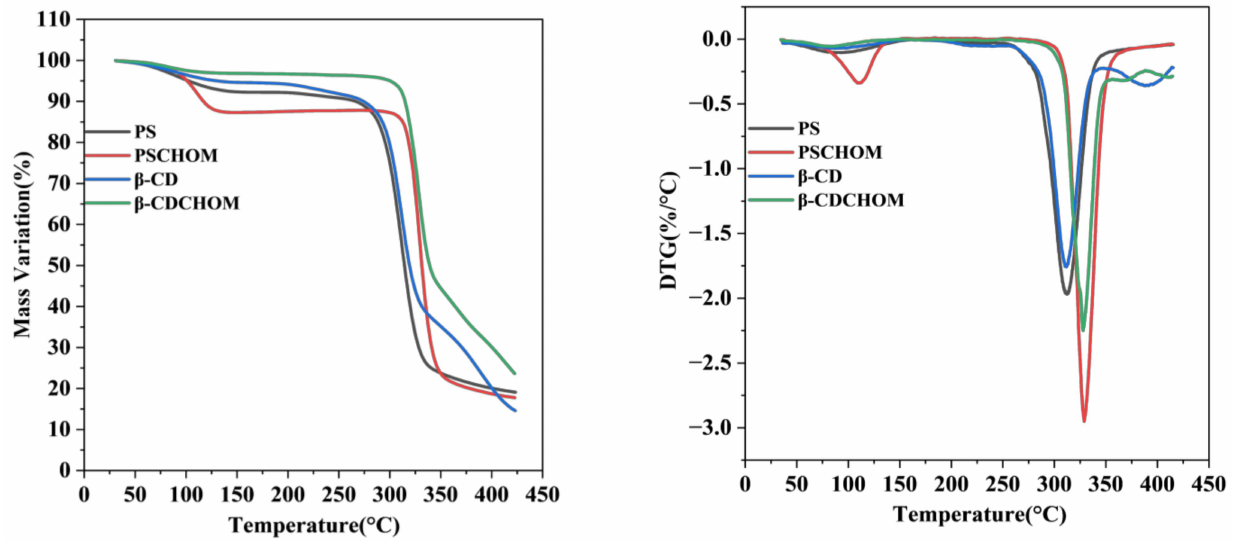
Figure 3. Integrated thermal analyses of β -CD, PS and their CHO microcapsules (( left ): TG; ( right ): DTG). β -CD, β -Cyclodextrin; PS, Porous starch; CHO, cold-pressed hickory oil; β -CDCHOM, β -cyclodextrin cold-pressed hickory oil microcapsule; PSCHOM, Porous starch cold-pressed hickory oil